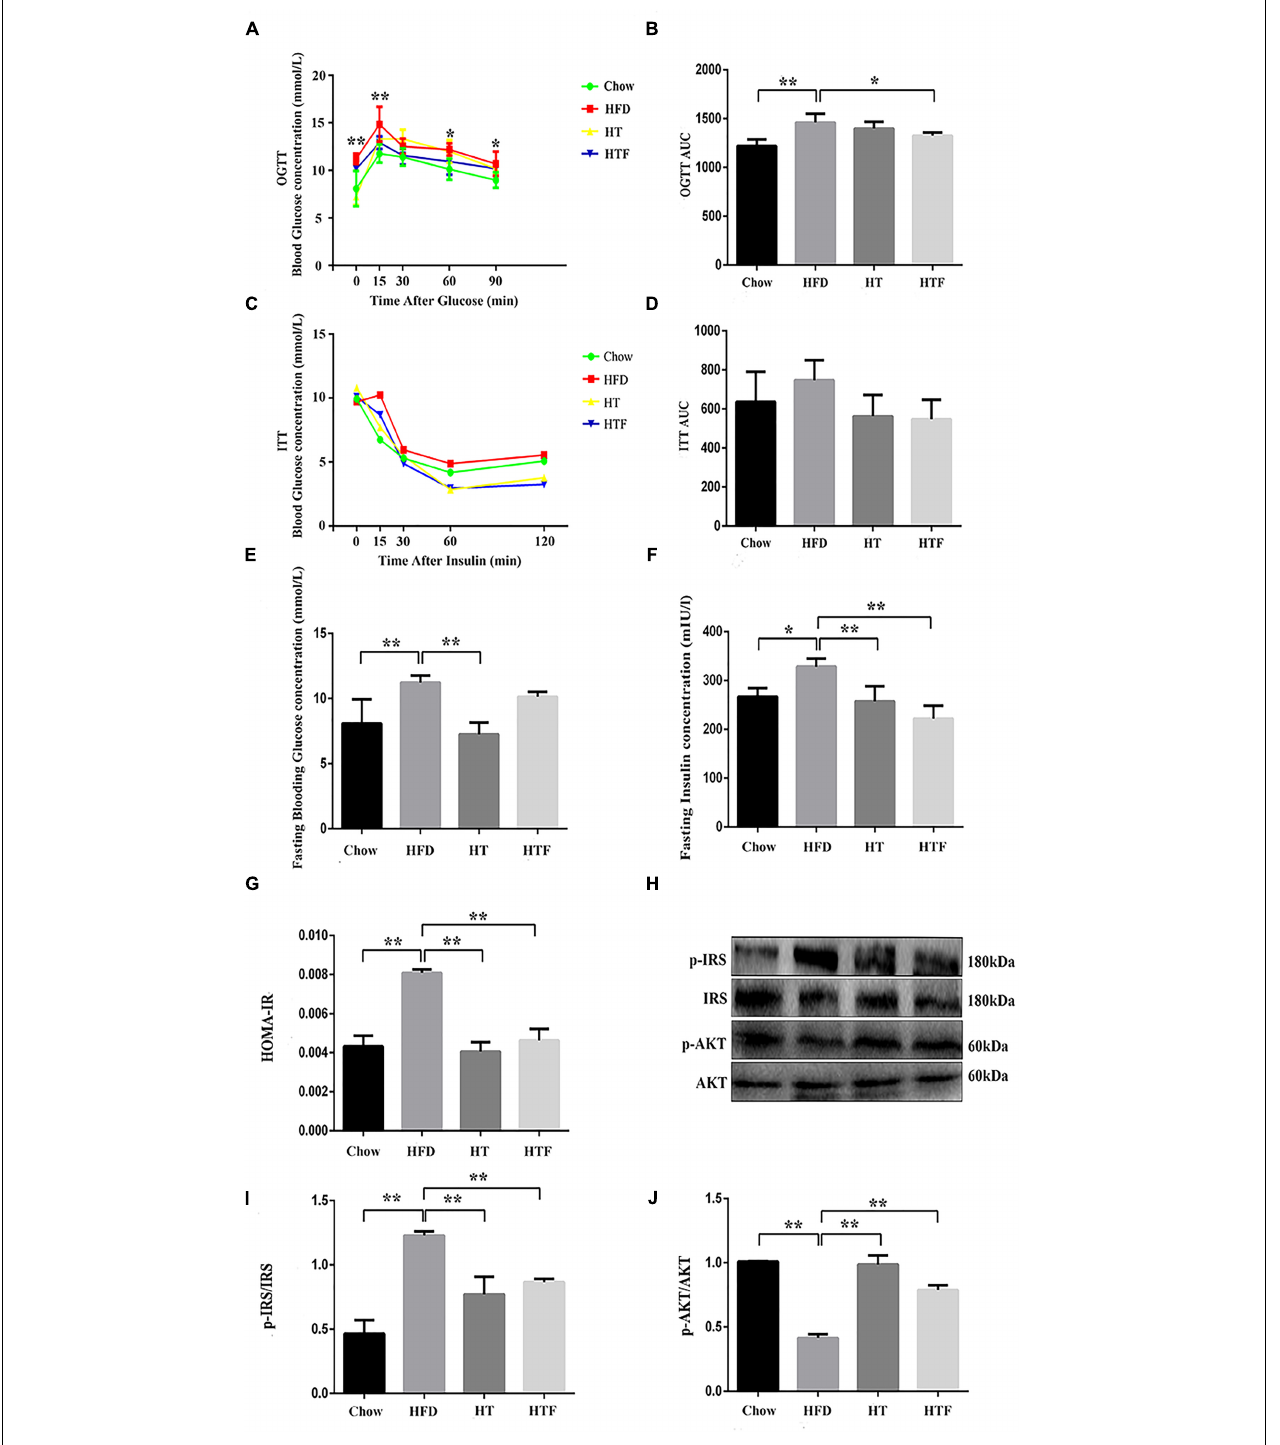
FIGURE 3 | HT and HTF improved IR in HFD-fed mice. Oral Glucose tolerance test (OGTT, 2 g/kg bw) after 8 weeks of intervention ∗ P < 0.05, ∗∗ P < 0.01 HFD vs. Chow (A) and the area under the curve (AUC) calculation (B) , Insulin tolerance test (ITT, 0.75 U/kg bw) after 8 weeks of intervention (C) and the AUC calculation (D) , Fasting blood glucose levels of each group (E) , Fasting blood insulin of each group (F) and HOMA-IR index after 8 weeks of intervention (G) . The expression of p-IRS and p-AKT in liver was assessed using western blot (H) . Bar graphs represent normalized data of p-IRS/IRS (I) and p-AKT/AKT (J) n = 3. Molecular weight markers were indicated as kilodaltons (kDa), Graph bars with statistically significant results ( P ≤ 0.05) based on one-way ANOVA analysis followed by Tukey’s honest significant difference post hoc tests. Data are shown as mean ± s.e.m ( ∗ P ≤ 0.05, ∗∗ P ≤ 0.01). HOMA-IR: homeostasis model assessment of insulin resistance.